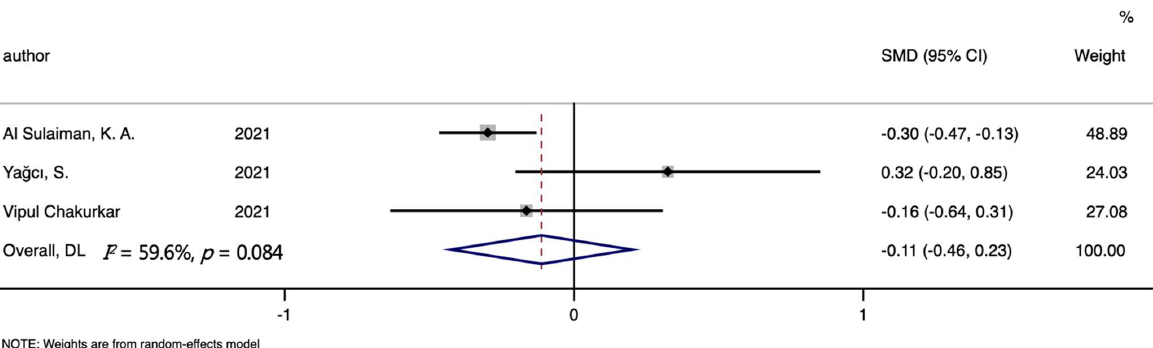
Figure 11. Forest plot of standard mean difference (SMD) with corresponding 95% confidence intervals (CIs) of studies [8,10,13] on TSAT levels in non-survivors and survivors. The solid diamond and horizontal line represent the study-specific effect and 95%CI, respectively; the size of the grey square is positively correlated with the weight distributed to each study in the meta-analysis. The center of open diamond with the vertical dashed line expresses the pooled SMD, and the width expresses the pooled 95%CI.